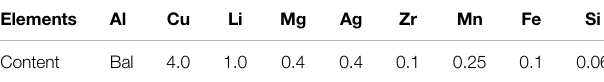
TABLE 1 | Contents of major elements in the as-received AA2195 Al alloy (wt%). Elements